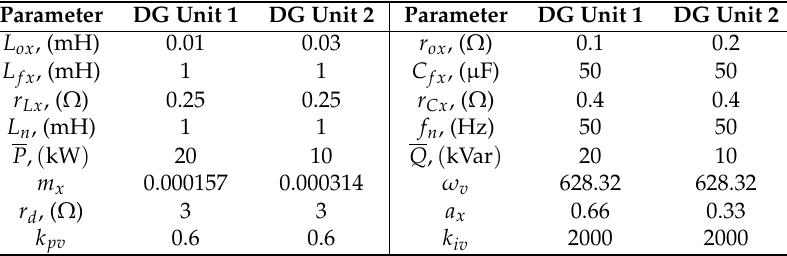
Table 2. System & control